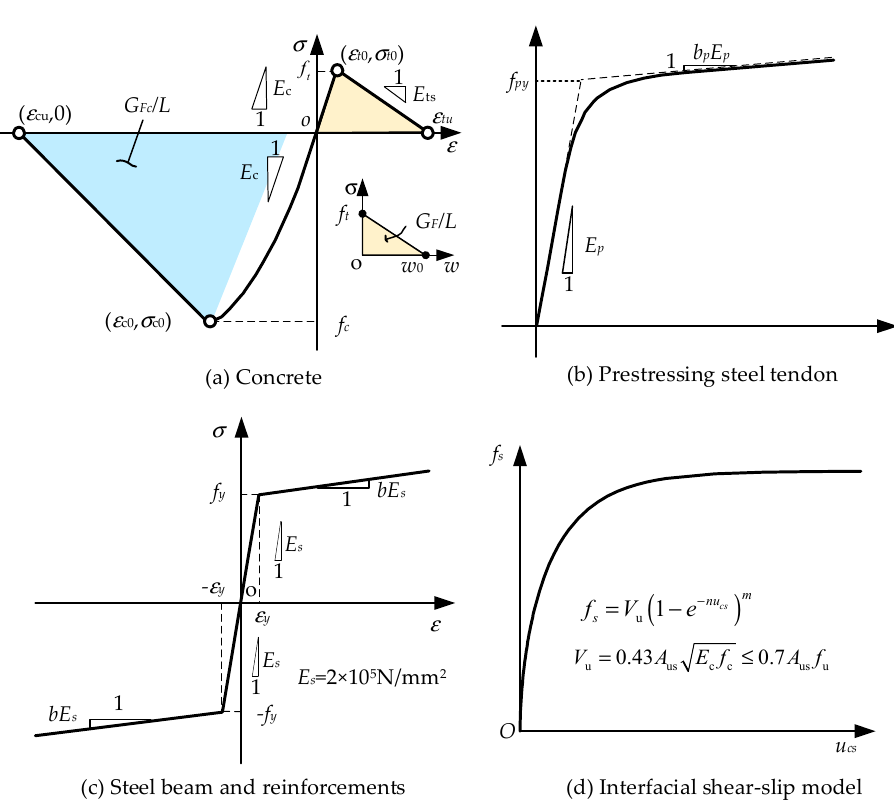
Figure 7. Constitutive model in the analysis of EPCB.